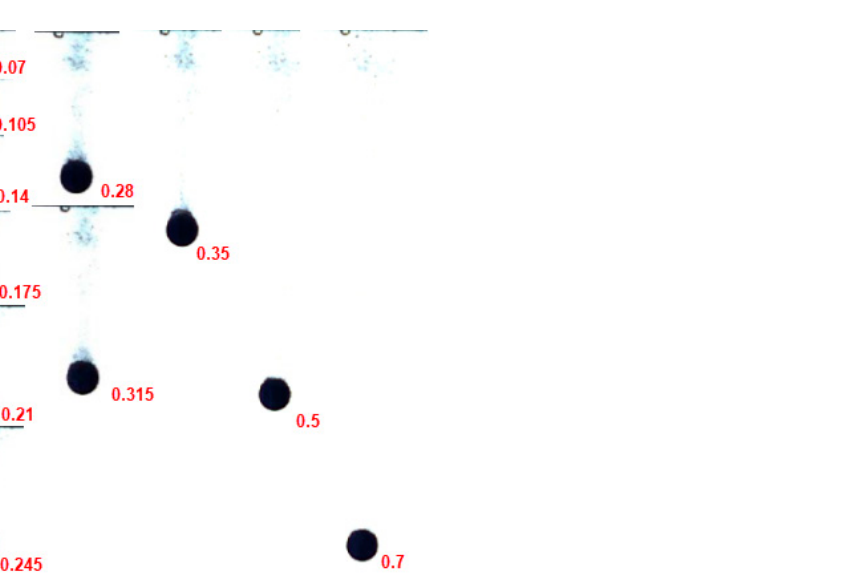
Figure 5. The dimensionless velocity versus the dimensionless time for the sphere at different tem- peratures where Vtcs is terminal velocity of cold sphere.